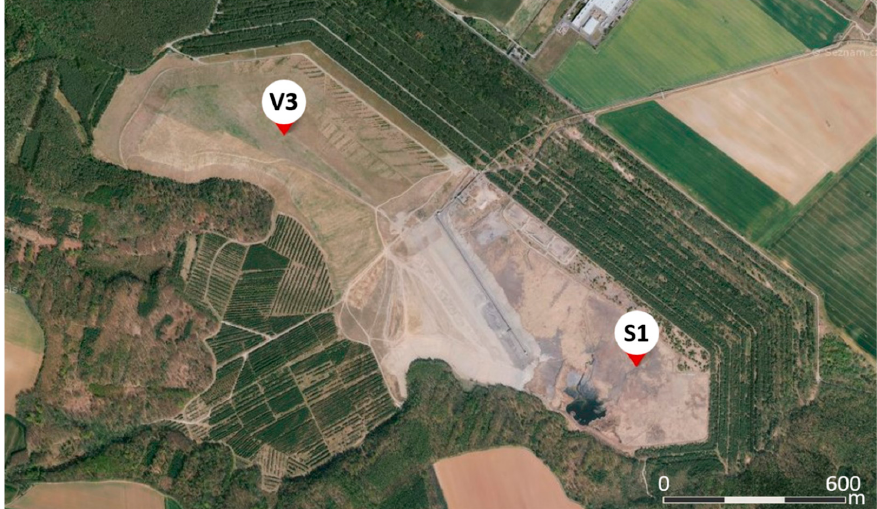
Figure 1. Location of core borehole V3 (50.4086175 N, 14.3813356 E) and S1 (50.4016497 N, 14.3977614 E) in stockpile Panský les, https://mapy.cz/ (accessed on 10 May